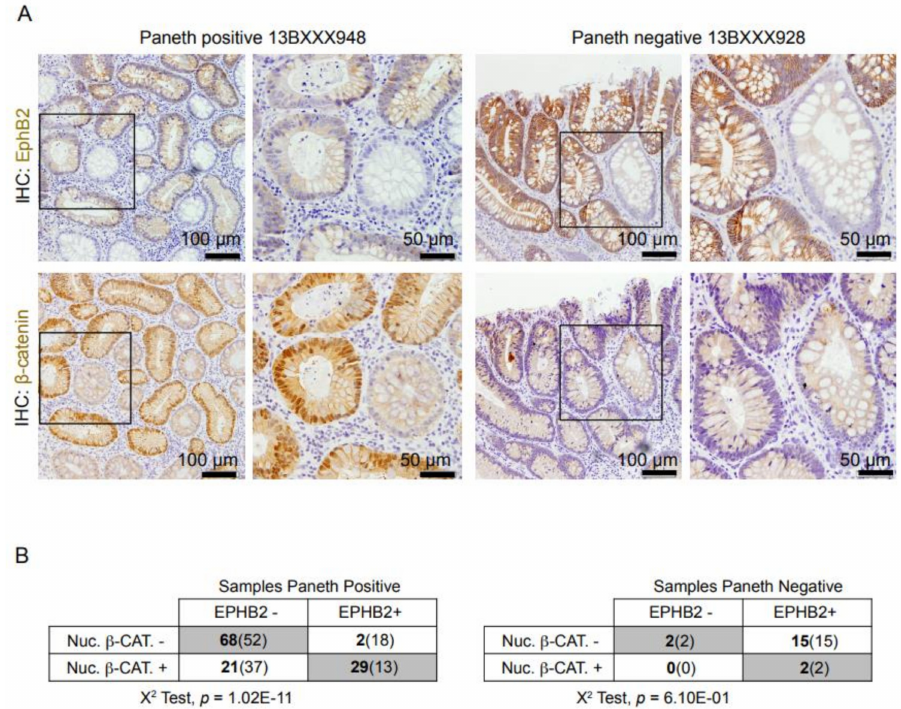
Figure 4. Expression of EPHB2 is linked with Wnt/ β -catenin activation in Paneth cell-positive adenomas. ( A ) Immunohistochemical (IHC) analysis of EPHB2 and β -catenin in sequential sections of the indicated adenoma samples. ( B ) Correlation analysis of the presence of nuclear β -catenin and LYZ positivity in the adenoma samples. The actual number of samples for each condition is shown in bold and the expected numbers from a random distribution are in the parentheses. A chi-square test was used to determine possible dependence between the analyzed